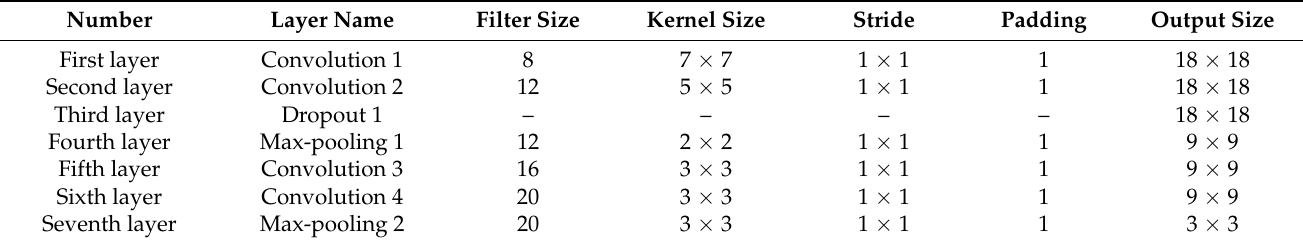
Table 3. Parameters configuration of DCNN.